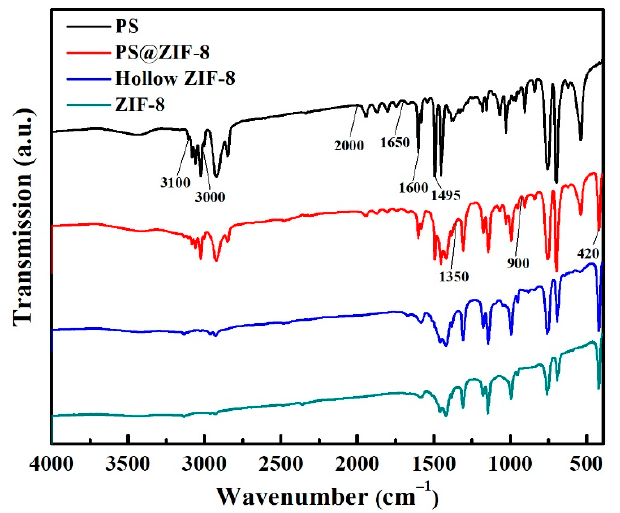
Figure 3. FTIR spectra of PS microspheres, ZIF ‐ 8, PS@ZIF ‐ 8, and hollow ZIF ‐ 8 particles.